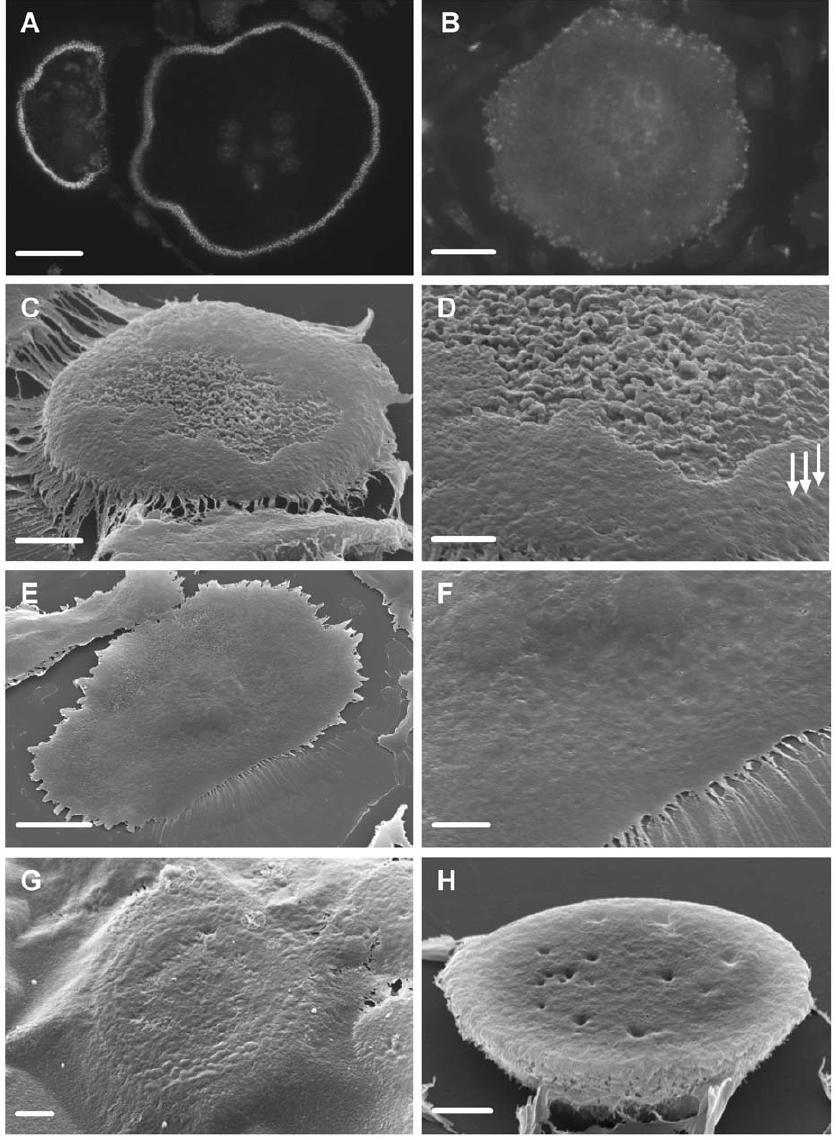
Figure 5. Vitronectin induces formation of ruffled border in osteoclasts. Glass coverslips were coated with nail-varnish. This was then coated with vitronectin or fibronectin (50 m g/ml). Next, osteoclasts were incubated on this surface for 5 hours in MEM/BSA with M-CSF (50 ng/ml), RANKL (30 ng/ml) and IL-1 a (10 ng/ml), with/without the cathepsin inhibitor E64 (3 6 10 2 7 M) or calcitonin (100 pg/ml). A,B: Phalloidin-stained preparations after incubation on vitronectin (A) or fibronectin (B). In A, individual podosomes can be discerned within the circumferential belt of podosomes. No podosomes are seen in the osteoclast that had been incubated on fibronectin. C–H: The discs of nail-varnish were separated from the glass coverslip, inverted onto a glass slide, dissolved in acetone, dehydrated in HMDS, and sputter-coated with gold for visualization in the SEM. C,D: undersurface of osteoclast incubated on vitronectin. The central area of the undersurface of the cell is filled with dense membrane folds, while the circumference lacks folds, but shows raised foci likely to represent podosomes (arrows). Note residual film of protein attached to the cell periphery. D: higher magnification of C. Note variation in density of membrane folds in the central area. E,F: Low and higher power view of undersurface of osteoclast incubated on fibronectin. The surface is relatively featureless, and lacks the domain organization apparent after incubation on vitronectin. G: The undersurface of osteoclasts was obscured by a protein film in cultures to which the cathepsin inhibitor E64 was added. Nevertheless, a peripheral belt of raised, podosome-like structures can be discerned through the film. H: The undersurface of osteoclasts incubated with calcitonin lacked membrane ruffles and podosome belts. Scale bars: A,B: 35 m m; C,F,H: 5 m m; D,G: 2 m m; E: 20 m m.